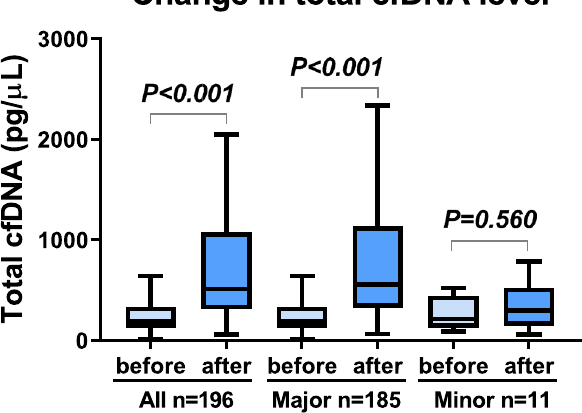
Figure 2. The difference of total cell-free DNA levels before and after surgery. Difference in total cell-free DNA (cfDNA) levels before and after urologic surgery.